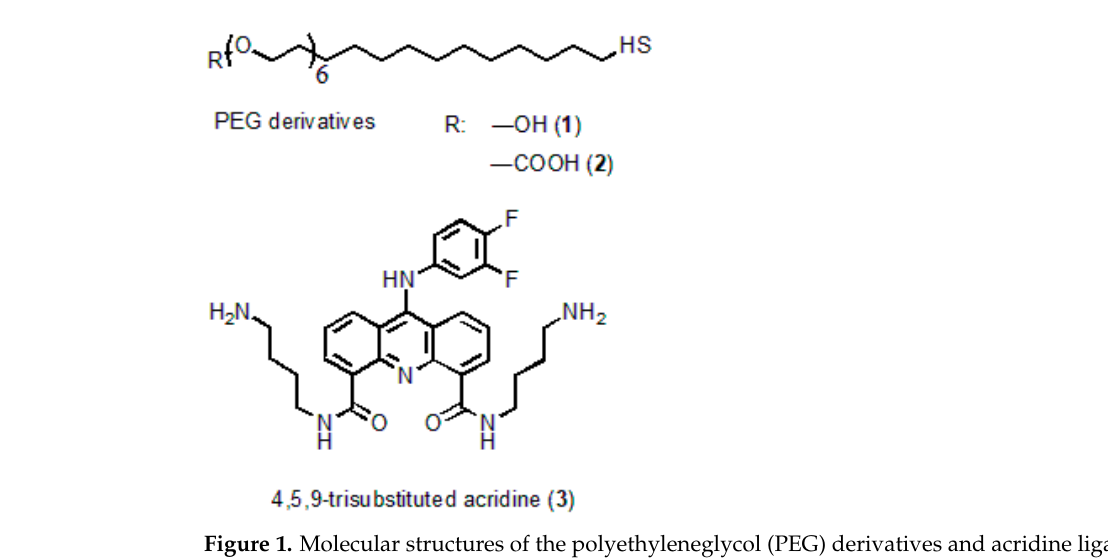
Figure 1. Molecular structures of the polyethyleneglycol (PEG) derivatives and acridine ligand.